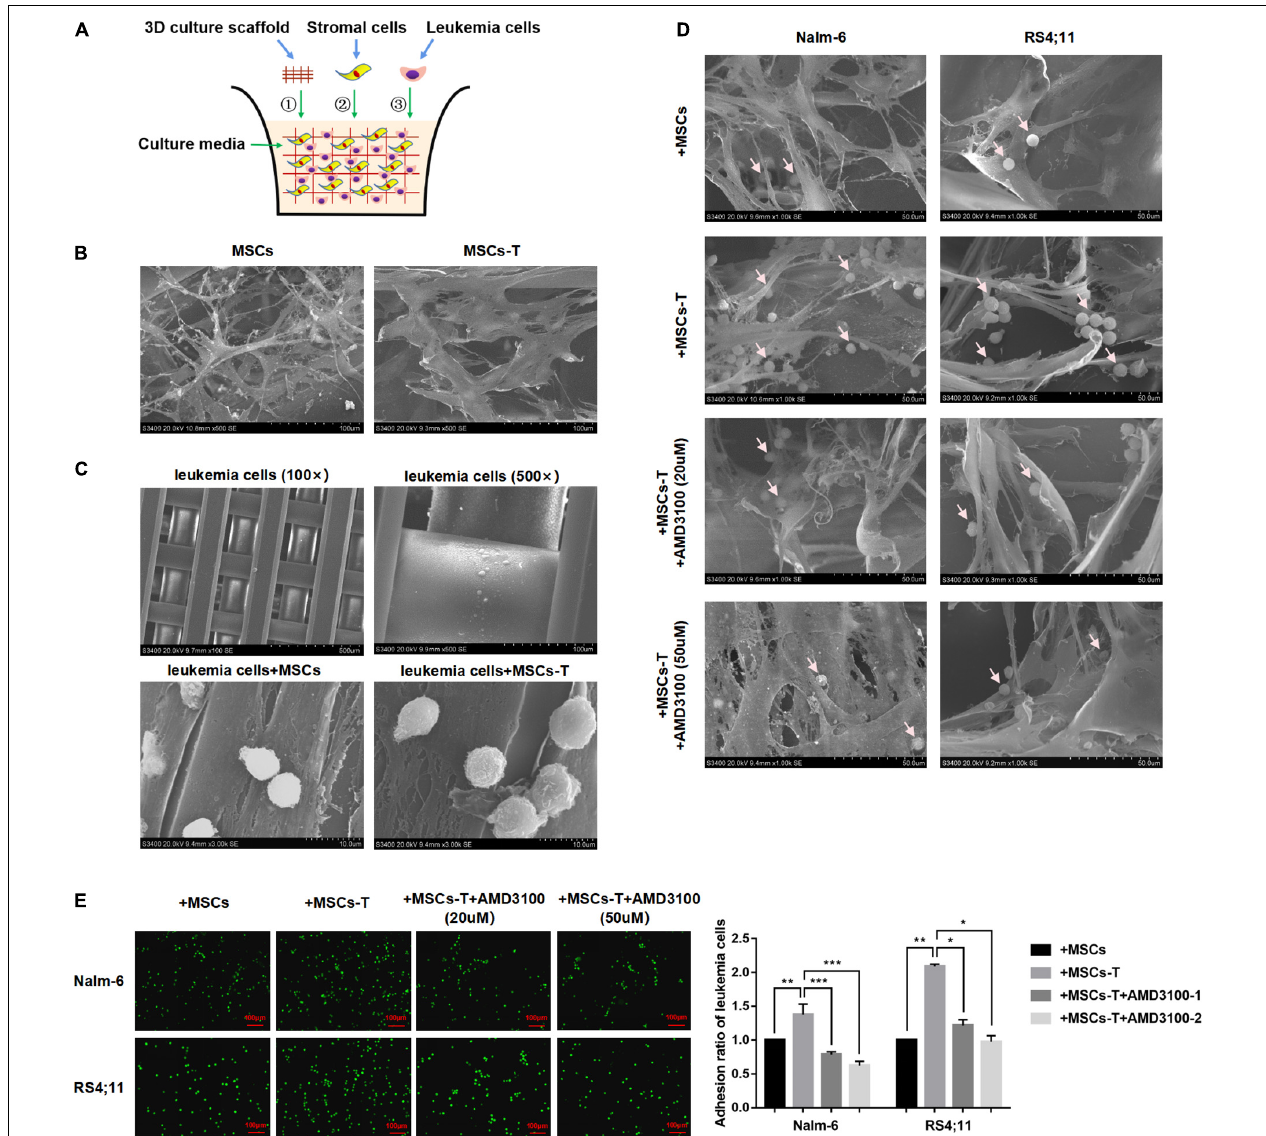
FIGURE 4 | AMD3100 weakened the interaction between MSCs with CAF-like phenotype and ALL cells by reducing the adhesion of leukemia cells to MSCs with CAF-like phenotype. (A) The structure simulation diagram of the 3D cell culture model. (B) The cell morphology of MSCs and TGF- β conditioned MSCs when they cultured in a 3D scaffold (500 × ). (C) Representative pictures of leukemia cells culture alone (100 × and 500 × ) or co-culture with MSCs/TGF- β conditioned MSCs (3000 × ) in the 3D scaffold. (D) The adhesion of leukemia cells to stromal cells when Nalm-6/RS4;11 cells were co-cultured with MSCs, TGF- β conditioned MSCs, TGF- β conditioned MSCs + AMD3100 (20 µ M) and TGF- β conditioned MSCs + AMD3100 (50 µ M) in a 3D scaffold for 24 h (1000 × ). The arrow in the figure refers to leukemia cells. (E) The adhesion of leukemia cells to stromal cells when Nalm-6/RS4;11 cells were co-cultured with MSCs, TGF- β conditioned MSCs, TGF- β conditioned MSCs + AMD3100 (20 µ M) and TGF- β conditioned MSCs + AMD3100 (50 µ M) for 24 h by using the fluorescence quantitative method (100 × , scale bars, 100 µ m). Each value indicates the mean ± SD of three or more independent experiments. In each independent repeated experiment, MSCs was isolated